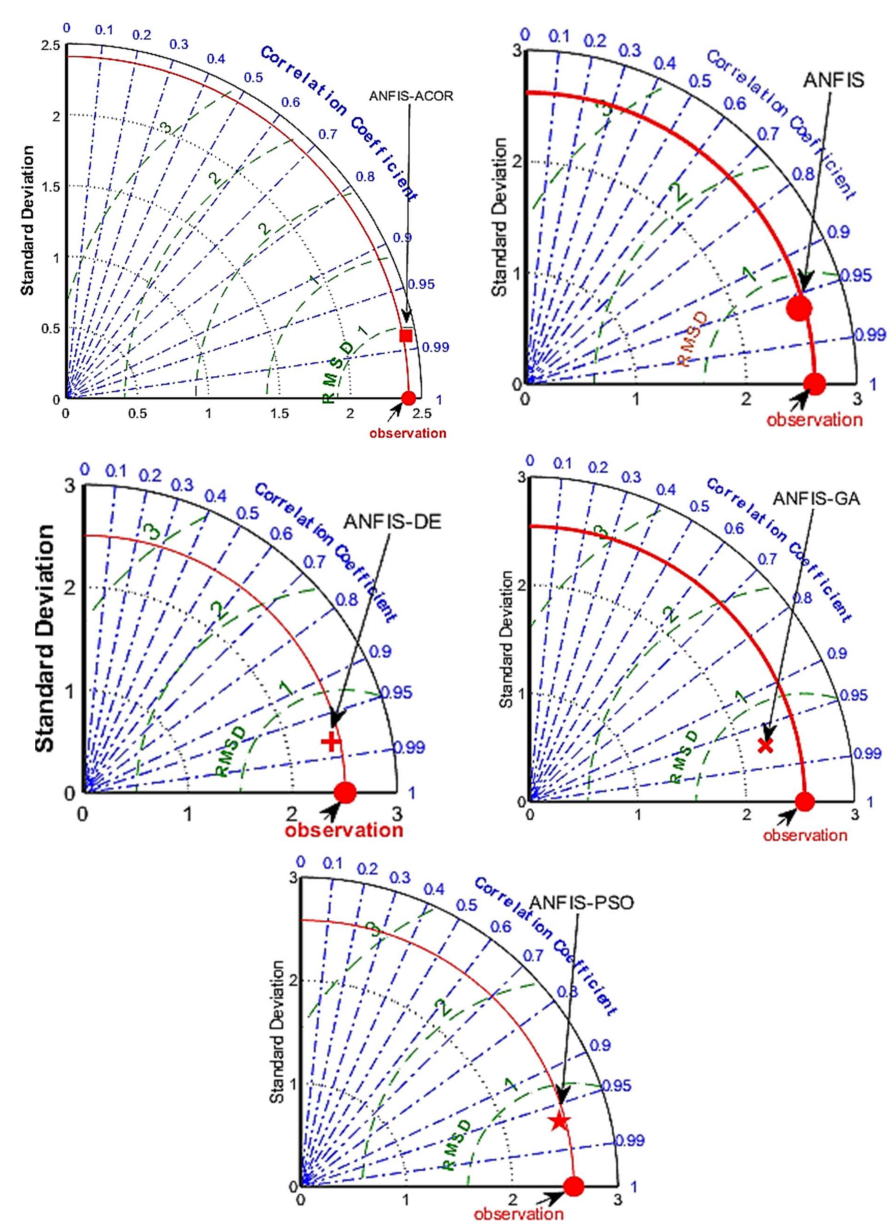
Figure 10. Taylor’s diagram for the selected input pattern of each model for observation well P2. The time input pattern prediction for the whole time period for all models is shown in Figure 11. Similar to the results obtained for observation well P1, hybrid models were able to recognize the trend in GWL. However, the ANFIS model resulted in high prediction errors for three time steps. As shown in the figure, these were December 2005, February 2011, and April 2014. Therefore, all models, except the ANFIS, are capable of a reliable GWL prediction in the study period. The simulation results show that for well P2 (observation well with river flow as an independent input variable), GWL dropped more than 8 m, i.e., ca. 0.57 m/year on average. Therefore, the annual drop in this area is more than that of the area of the observation well